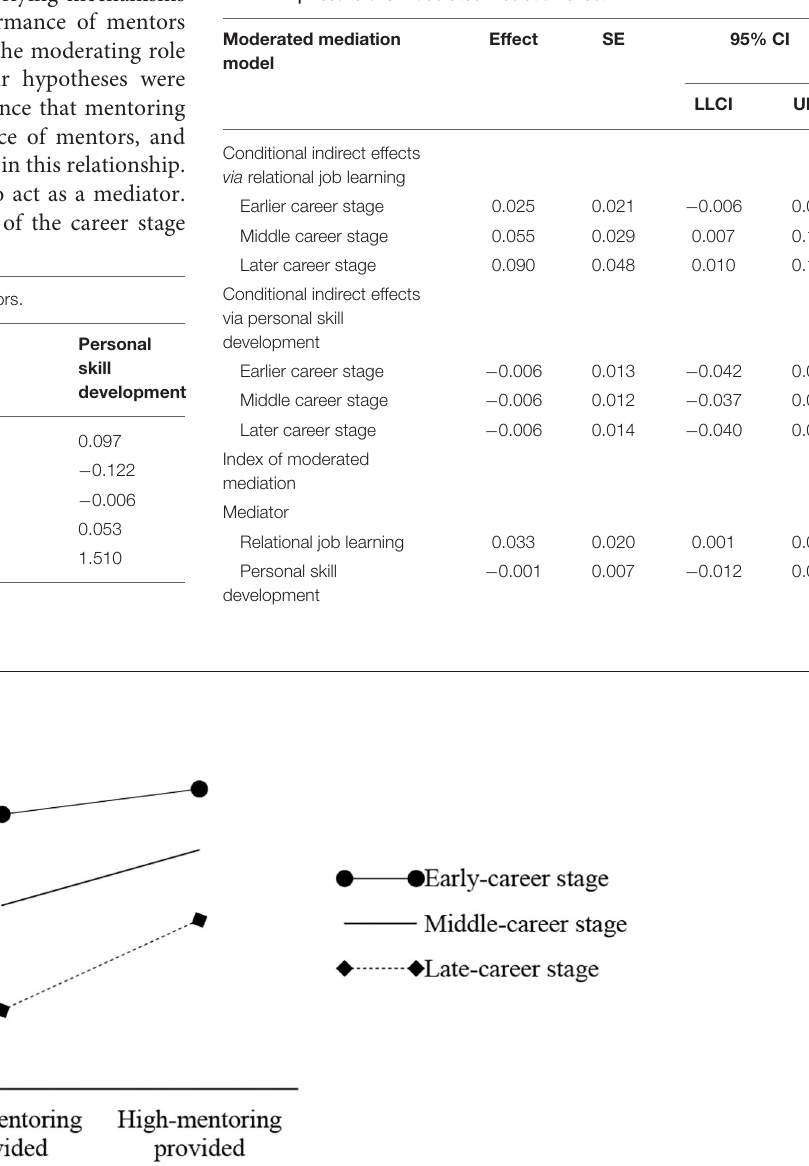
FIGURE 2 | The moderation effect of career stage on the relationship between mentoring provided and relational job learning.